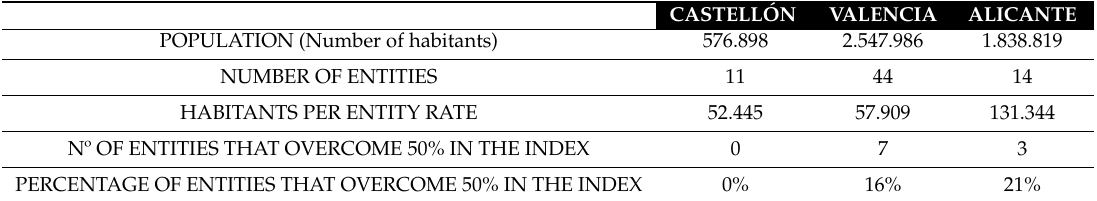
Table 6. Relation of population and number of entities by province (source: Instituto Nacional de Estad í